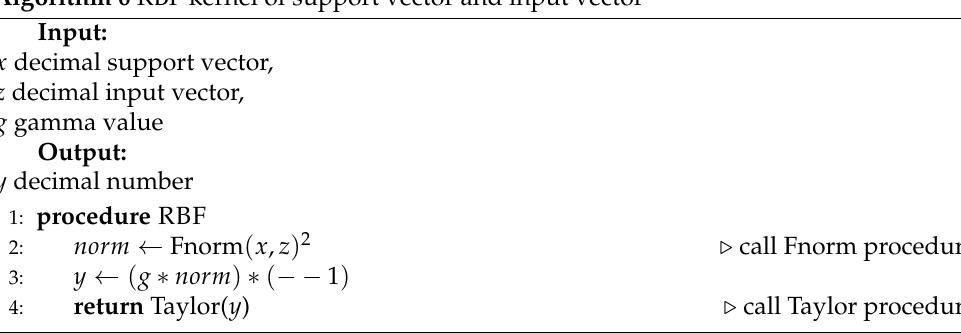
Algorithm 6 RBF kernel of support vector and input